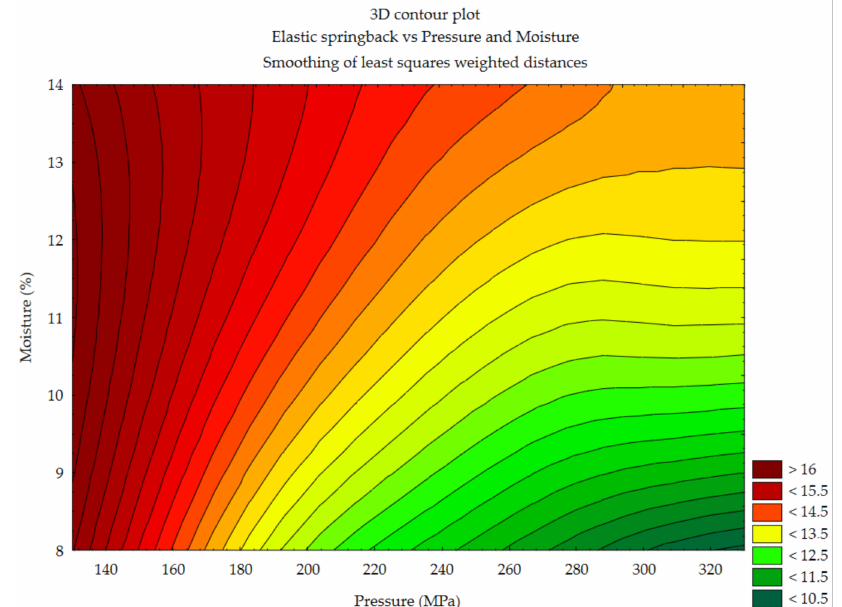
Figure 6. Elastic springback vs. pressure and moisture—silphium.